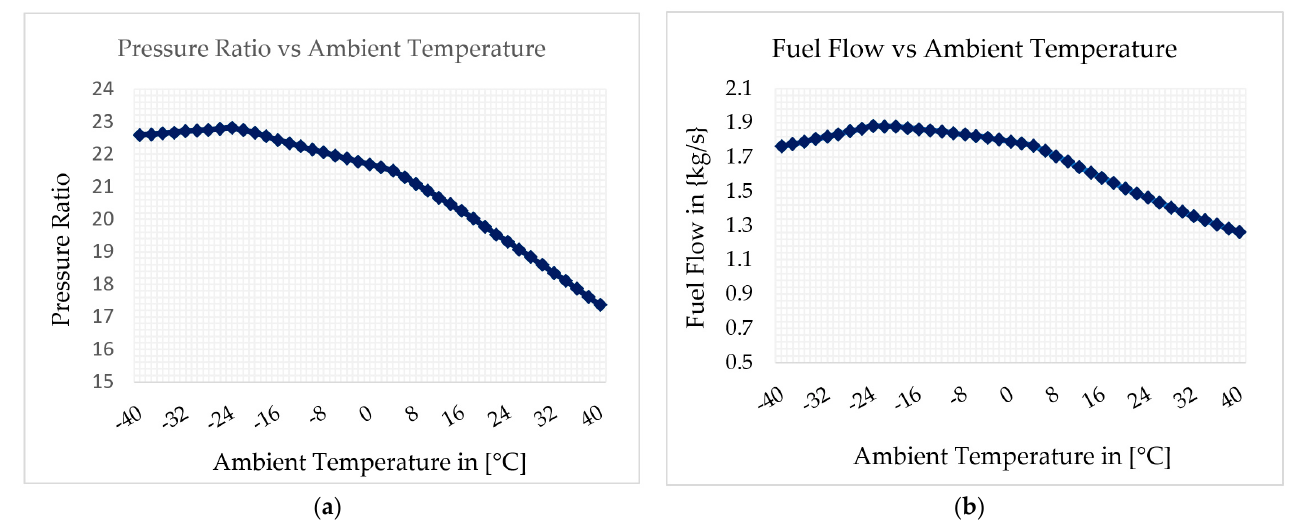
Figure 18. The effect of ambient temperature variation: ( a ) on pressure ratio, ( b ) on fuel flow. Pressure ratio versus ambient temperature and fuel flow versus ambient temperature